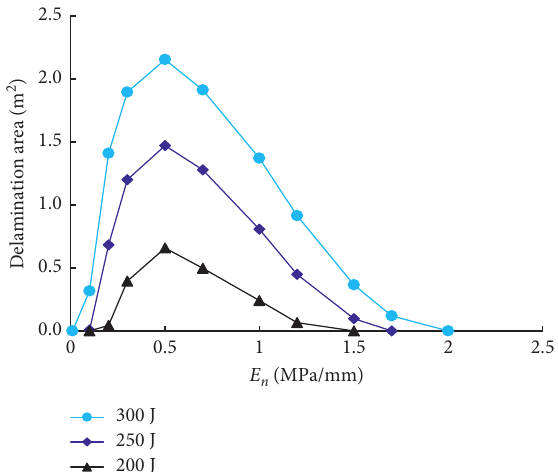
Figure 25: The delamination area versus E